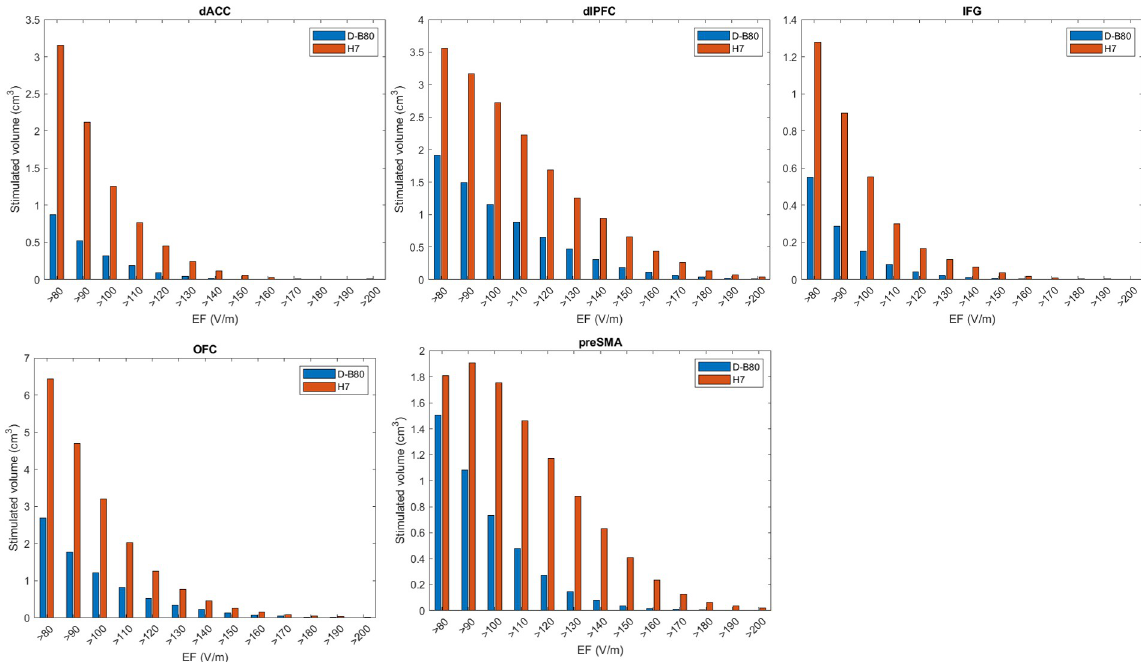
Fig 6. Distribution of values of EF intensity within specific brain regions. Histograms of distribution of the volume in cm 3 according to the induced electric field range for the D–B80 and H7 coils, are plotted for five brain regions (dACC, dlPFC, IFG, OFC and pre–SMA). Field columns are in bins of 10 V/m. Shown the averaged results of all the 22 simulated head